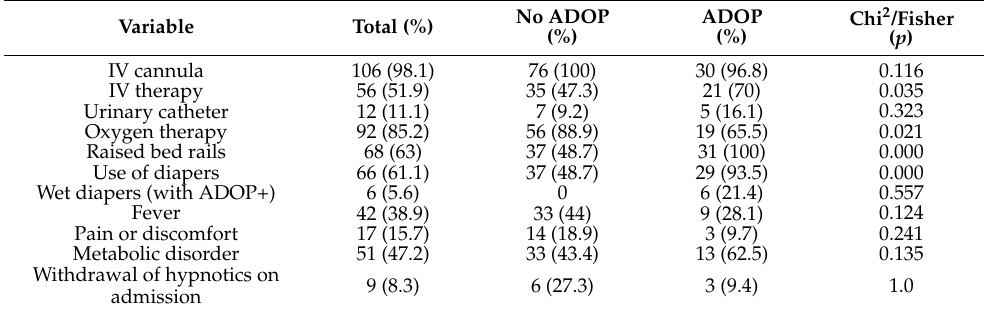
Table 3. Precipitant factors for ADOP.